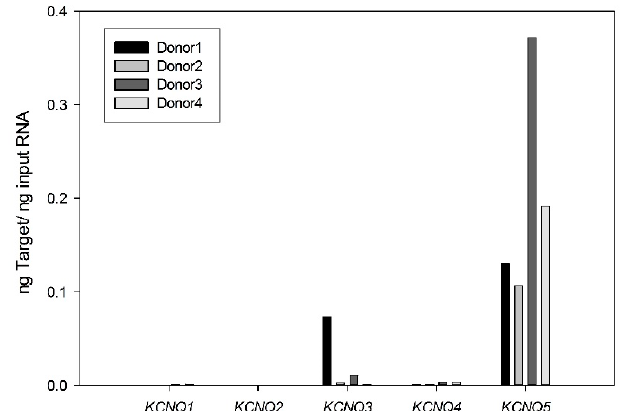
Figure 1. Expression of different KCNQ isoforms in cultured human airway smooth muscle cells (HASMCs). Expression levels of mRNAs for KCNQ1 – 5 were estimated using quantitative real time RT-PCR in HASMCs. Target abundance values represent four different donor cultures (means from triplicate measurements from each sample).